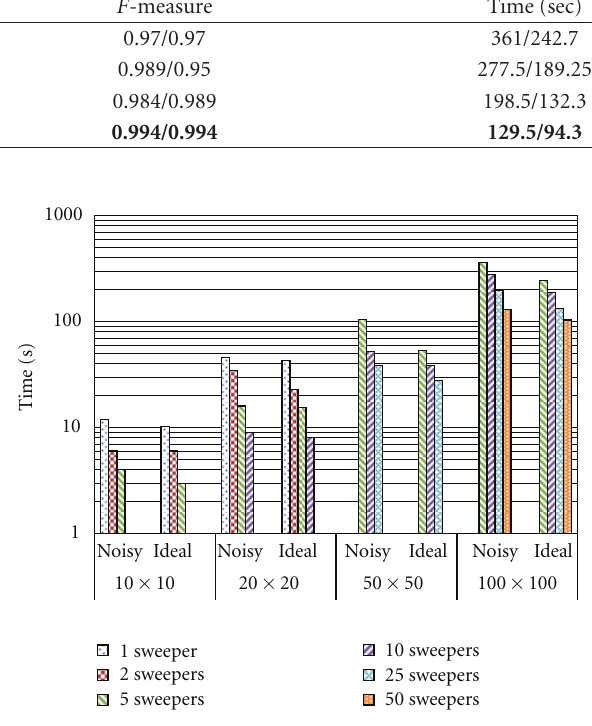
Figure 14: Time in noisy versus ideal sensor